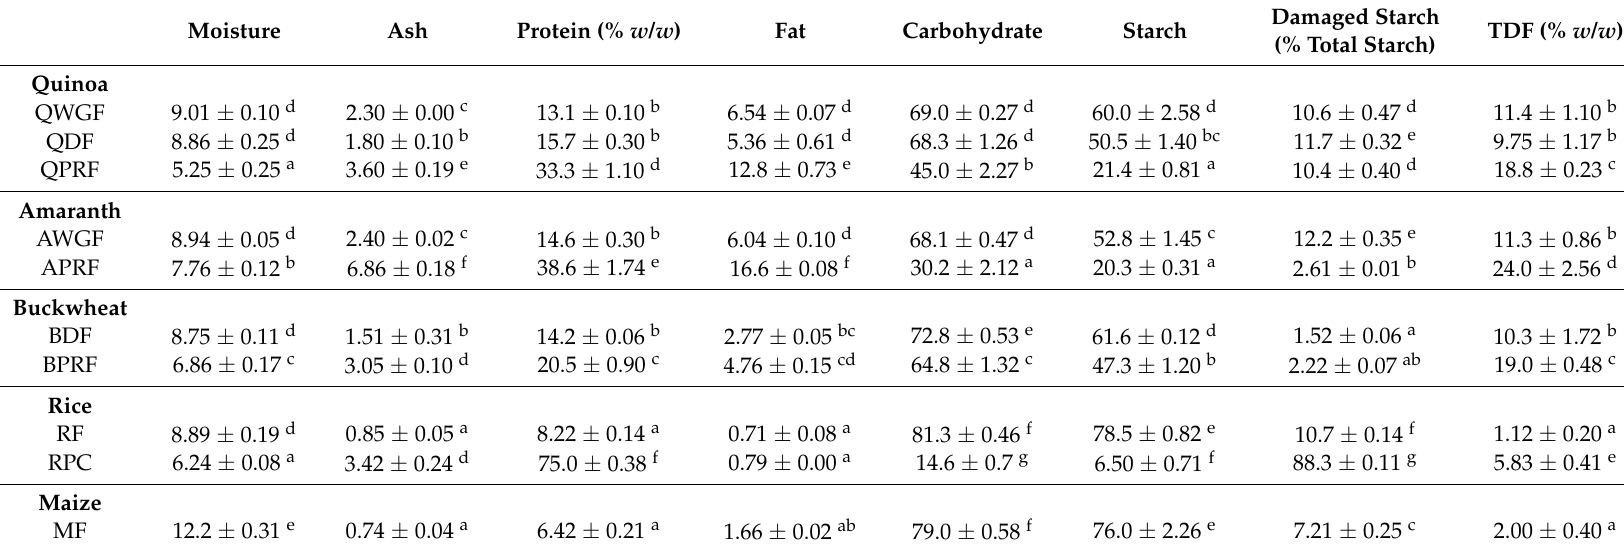
Table 1. Macronutrient composition of quinoa wholegrain flour (QWGF), quinoa dehulled flour (QDF), quinoa protein-rich flour (QPRF), amaranth wholegrain flour (AWGF), amaranth protein-rich flour (APRF), buckwheat dehulled flour (BDF), buckwheat protein-rich flour (BPRF), rice flour (RF), rice protein concentrate (RPC), and maize flour (MF) . Total dietary fibre (TDF). Values are means ± standard deviations of data from triplicate